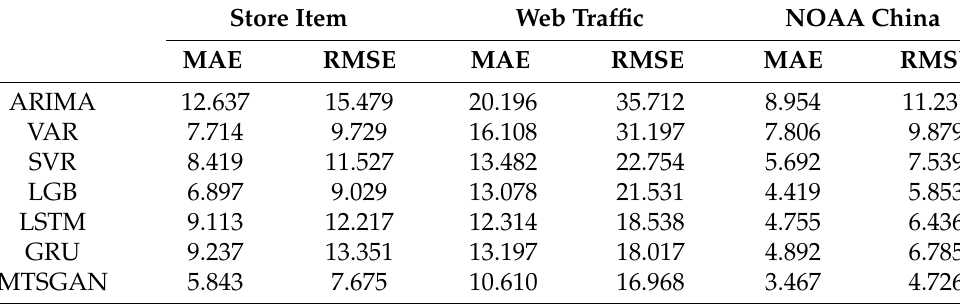
Table 1. The prediction results of the MTSGAN and other methods.